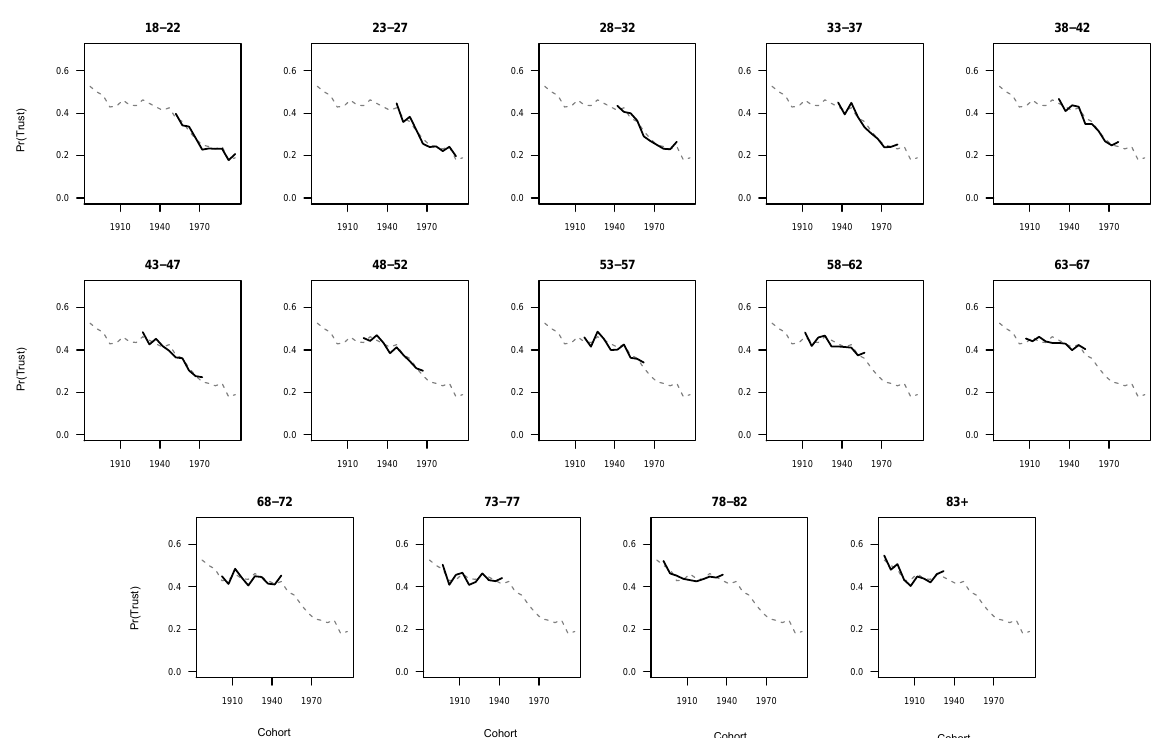
Figure 11: Trellis plot of local diachronic cohort curves. Notes: Each panel displays the (overall) diachronic cohort curve overlaid with local diachronic cohort curves. Horizontal axes are age in years, whereas vertical axes are predicted probability of social trust. Calculations are based on θ 2 ( k − k ∗ ) + k = 1, . . . , K in each age group i . Local curves are shown with solid lines, whereas the overall curve is shown with a dashed line. Each local curve has a length equal to the number of periods in the data ( J = 10). All estimates are based on a diachronic L-APC logistic regression model. Outcome is social trust, coded so that 1 = “can trust” while 0 = “can’t be too careful” or “depends.” Results adjusted using sampling